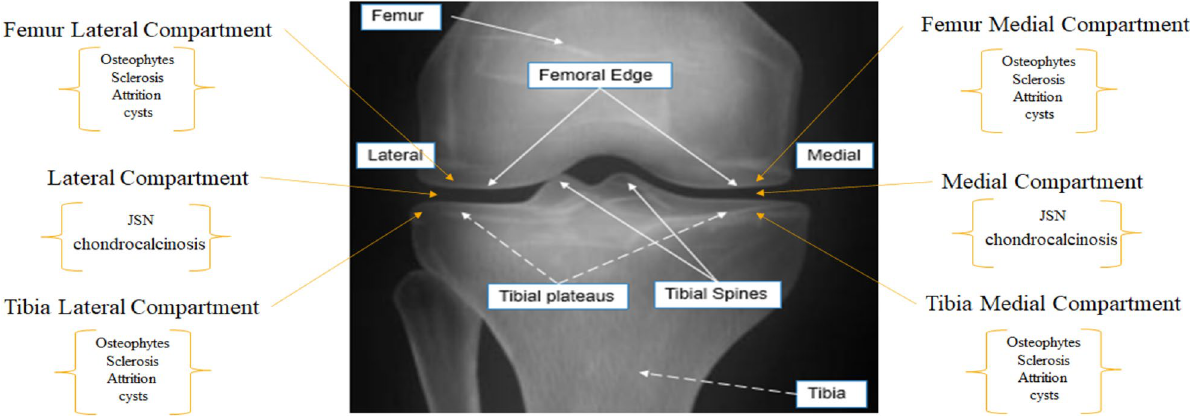
Figure 1. Radiographic knee anatomy and OA feature locations.